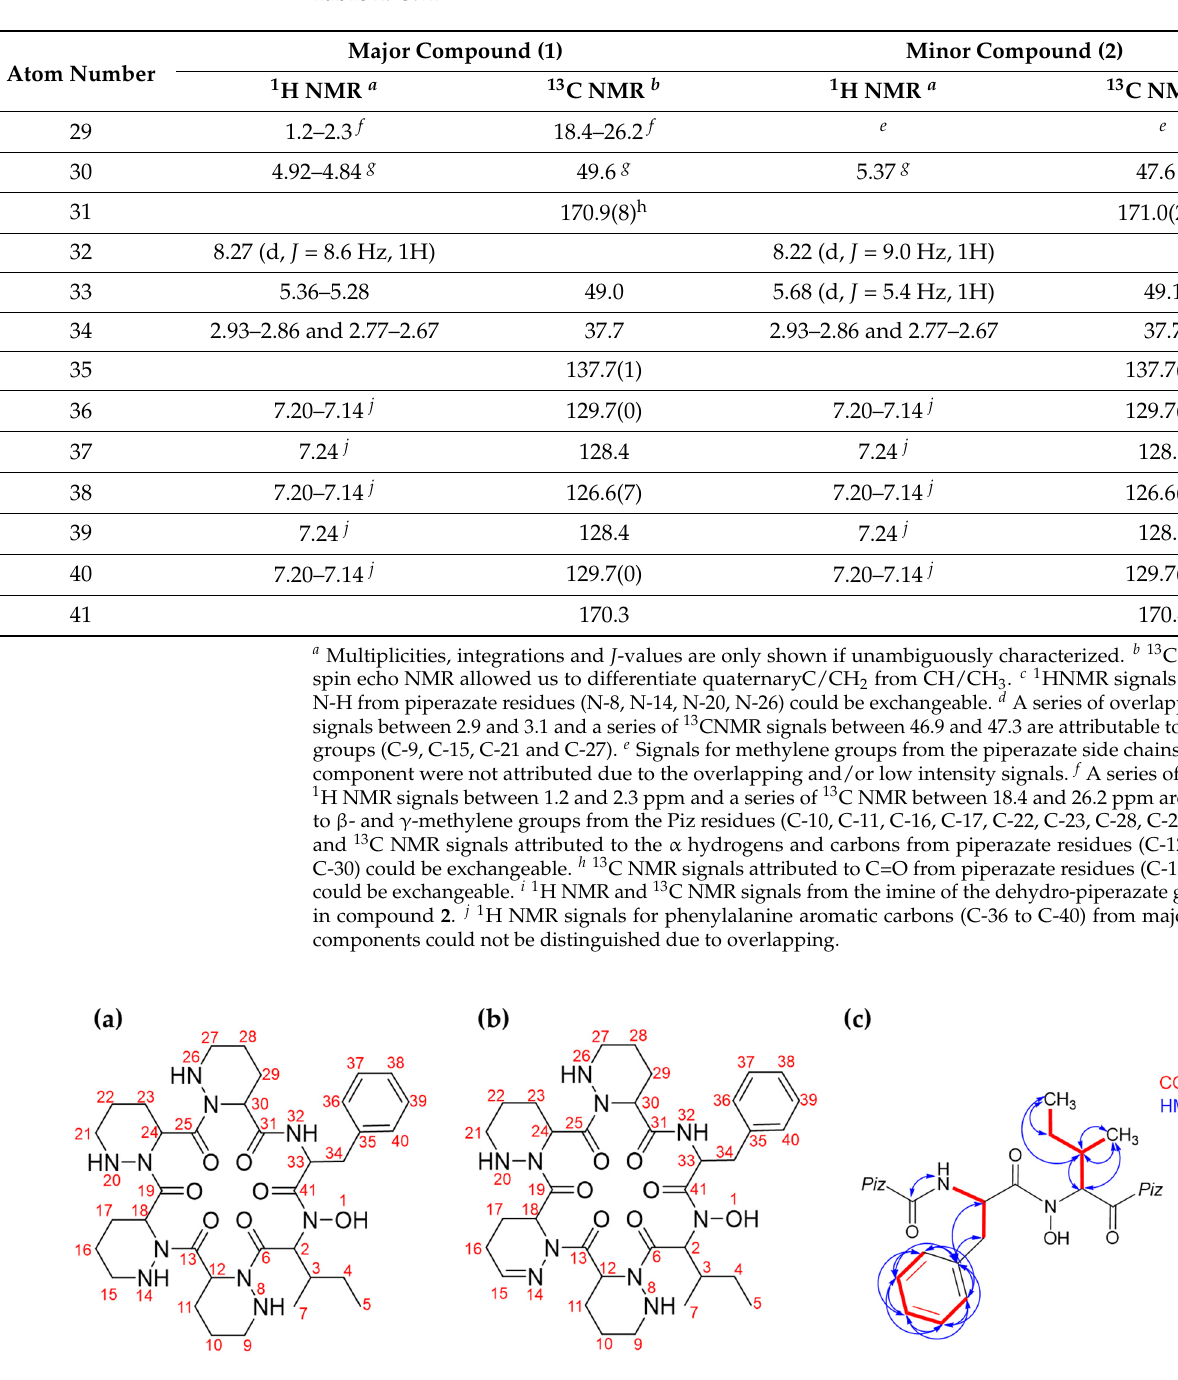
Figure 5. Structure elucidation of compounds 1 and 2 by NMR. ( a ) Compound 1 . ( b ) Compound 2 . ( c ) COSY and HMBC correlations that allowed to unambiguously confirm the location of the hy- droxylation on compound 1 . See supplementary Figures S2–S6 . Table 2. Assignment of NMR signals of the major ( 1 ) and minor ( 2 ) components of the semi purified sample.